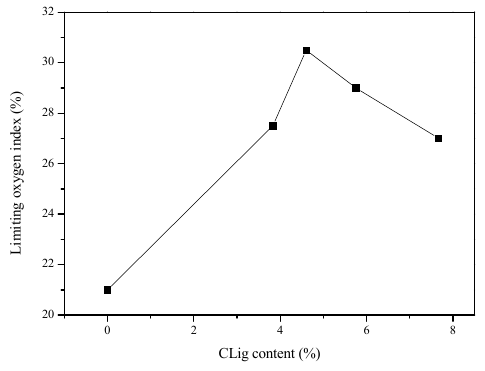
Figure 3. Effect of CLig content on flame retardancy of PLA/IFR composites with a total loading of 23 wt%.